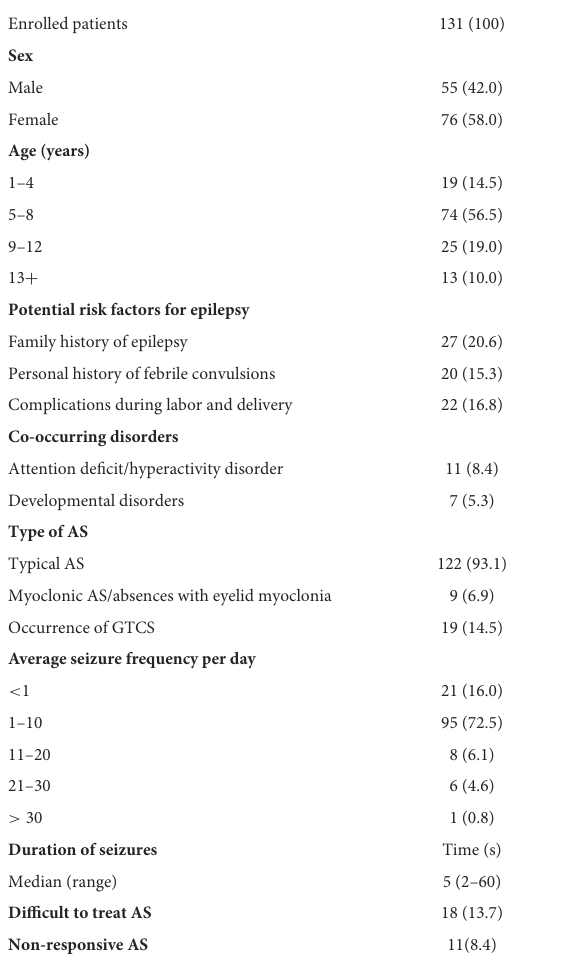
TABLE 1 Baseline and clinical characteristics of the